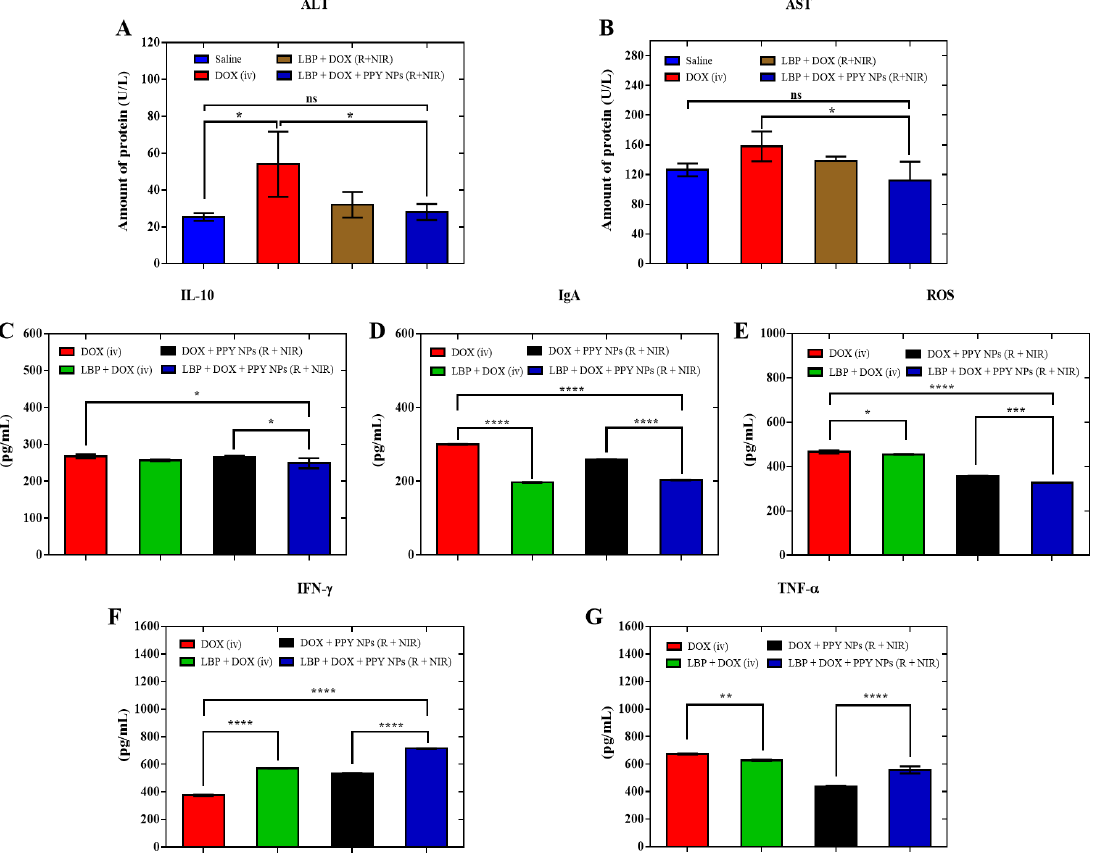
Figure 6. ALT ( A ) (n = 3; * p < 0.05); AST ( B ) (n = 3; * p < 0.05); ELISA of cytokines in mice sera injected with samples: IL-10 ( C ), IgA ( D ), ROS ( E ), IFN- γ ( F ), and TNF- α ( G ) (n = 4; * p < 0.05, ** p < 0.01, *** p < 0.001, **** p < 0.0001, ns, not statistically significant.). Results are presented as the mean ±